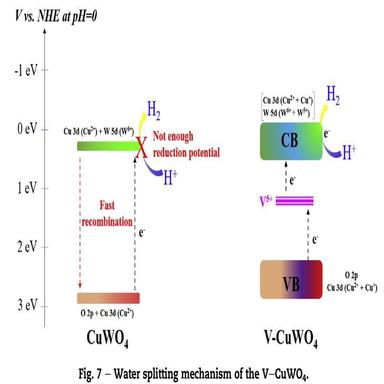
Hydrogen production of recycled 6VeCuWO4.